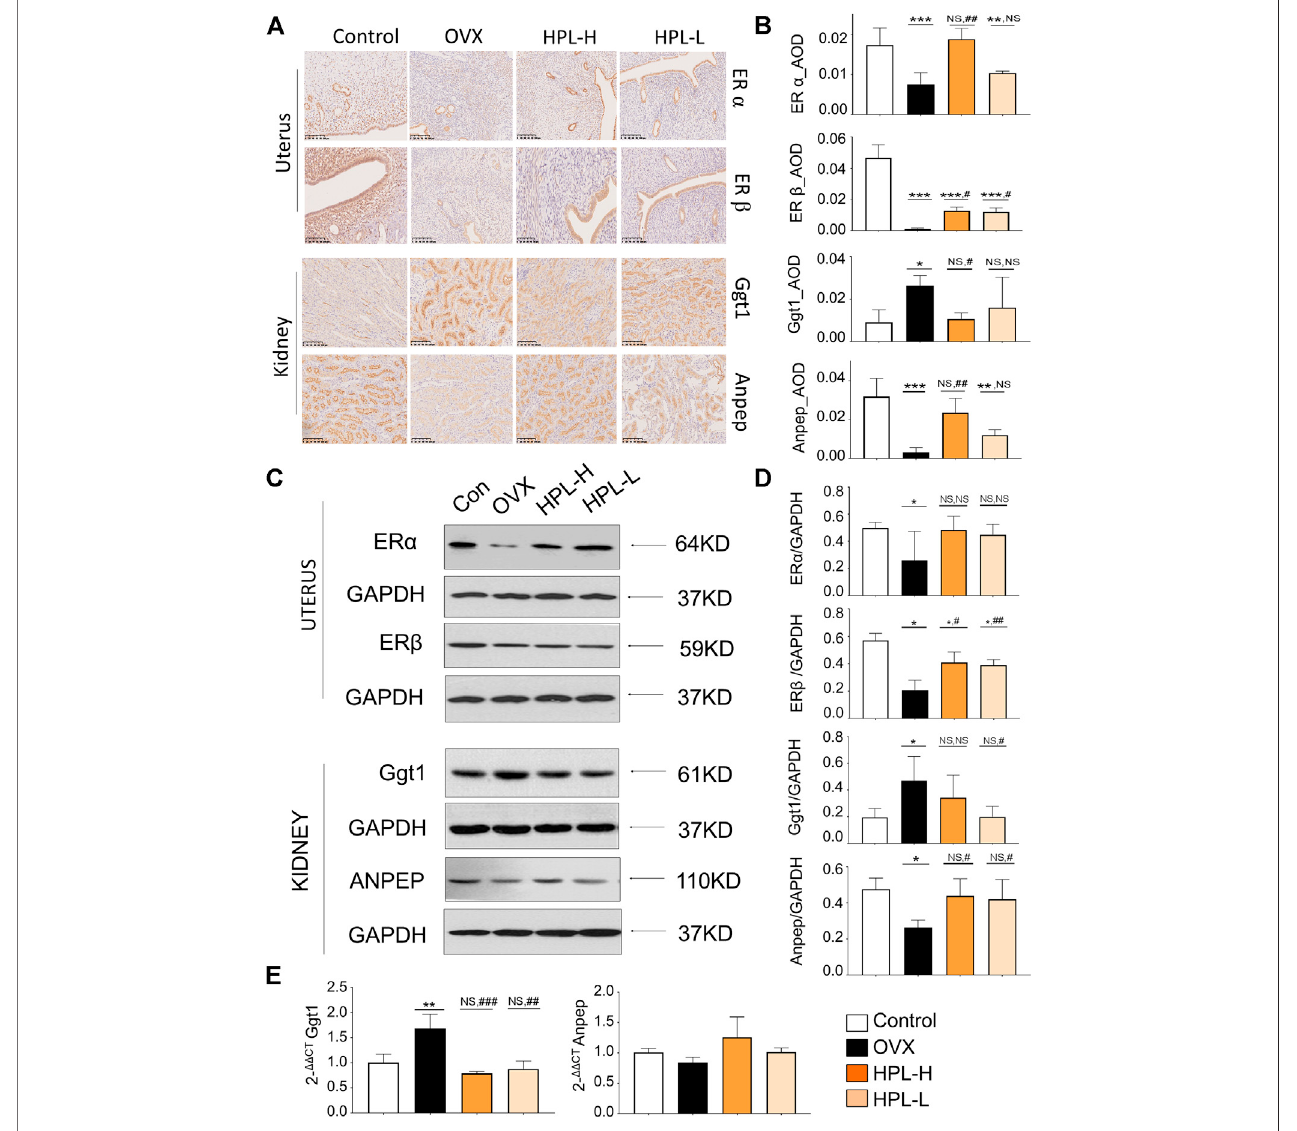
FIGURE 4 | Immunohistochemistry (IHC) and western blot assays of HPL-treated samples. (A) IHC revealed a disturbed morphology of uterine and renal tissues (DAB staining, scale bar, 200 µm). (B) The IHC average optional density (AOD) ratio. (C) Representative images of ER α , ER β , Ggt1, and Anpep levels detected using western blotting. (D) Representative quantitation of ER α , ER β , Ggt1, and Anpep levels detected using western blotting. (E) qRT-PCR analysis of renal levels of the Ggt1 and Anpep mRNAs. The results of the statistical analysis are presented in bar charts (mean ± s . e.m.). HPL therapy dosage: HPL-H, 300 mg/kg/d; HPL-L, 80 mg/kg/d. *p < 0.05, **p < 0.005, and ***p < 0.0005 compared with control rats; #p < 0.05, ##p < 0.005, and ###p < 0.0005 compared with OVX rats. NS, not signi fi cant.